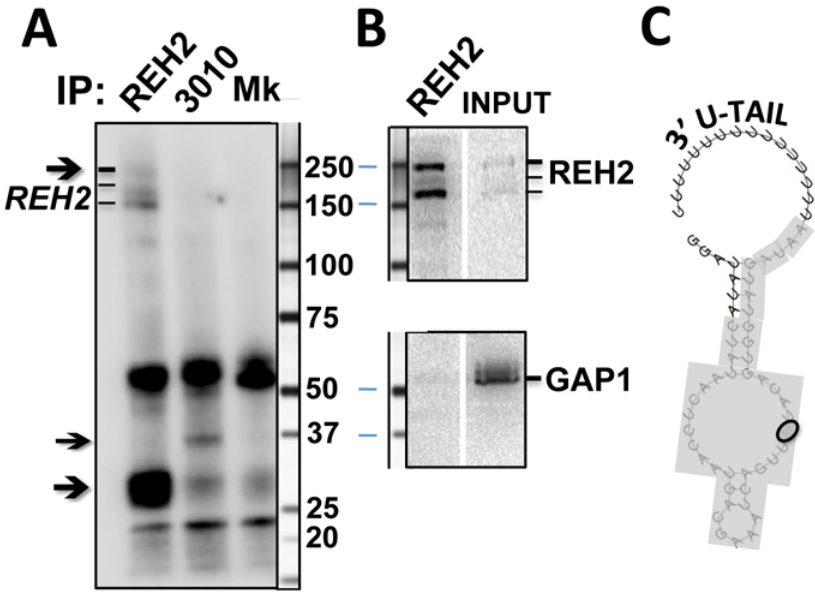
Fig 9. Photo-crosslinks in REH2 and 3010 pulldowns with an initiating gRNA. Antibody pulldowns of sedimentation fractions 4-to-6 in mitochondrial extracts from RNAP knockdown cells (Fig 7B) analyzed by (A) Site-specific crosslinking (365-nm UV) with a model initiating gRNA for mRNA A6 that includes a photo- reactive thio-U and 32 P in a single phosphodiester bond, or (B) Western blots of REH2 or GAP1 with size markers in the REH2 IP or the 15S input fractions 4-to-6. (C) Mfold prediction [46] of the secondary structure of the gRNA in panel A. The photo-reactive base is circled and guide sequence is inclosed in the gray box. Arrows in A indicate crosslinks in the REH2 or 3010 IP, including at ~30 kDa and, apparently, REH2 itself in the REH2 IP. A mock control (Mk) used an irrelevant affinity-purified